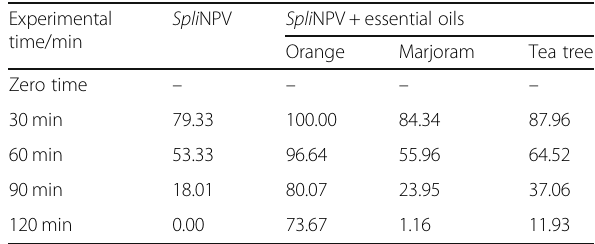
Table 1 (%) OAR of the effect of orange, marjoram, and tea tree oils as protective additives to Spodoptera